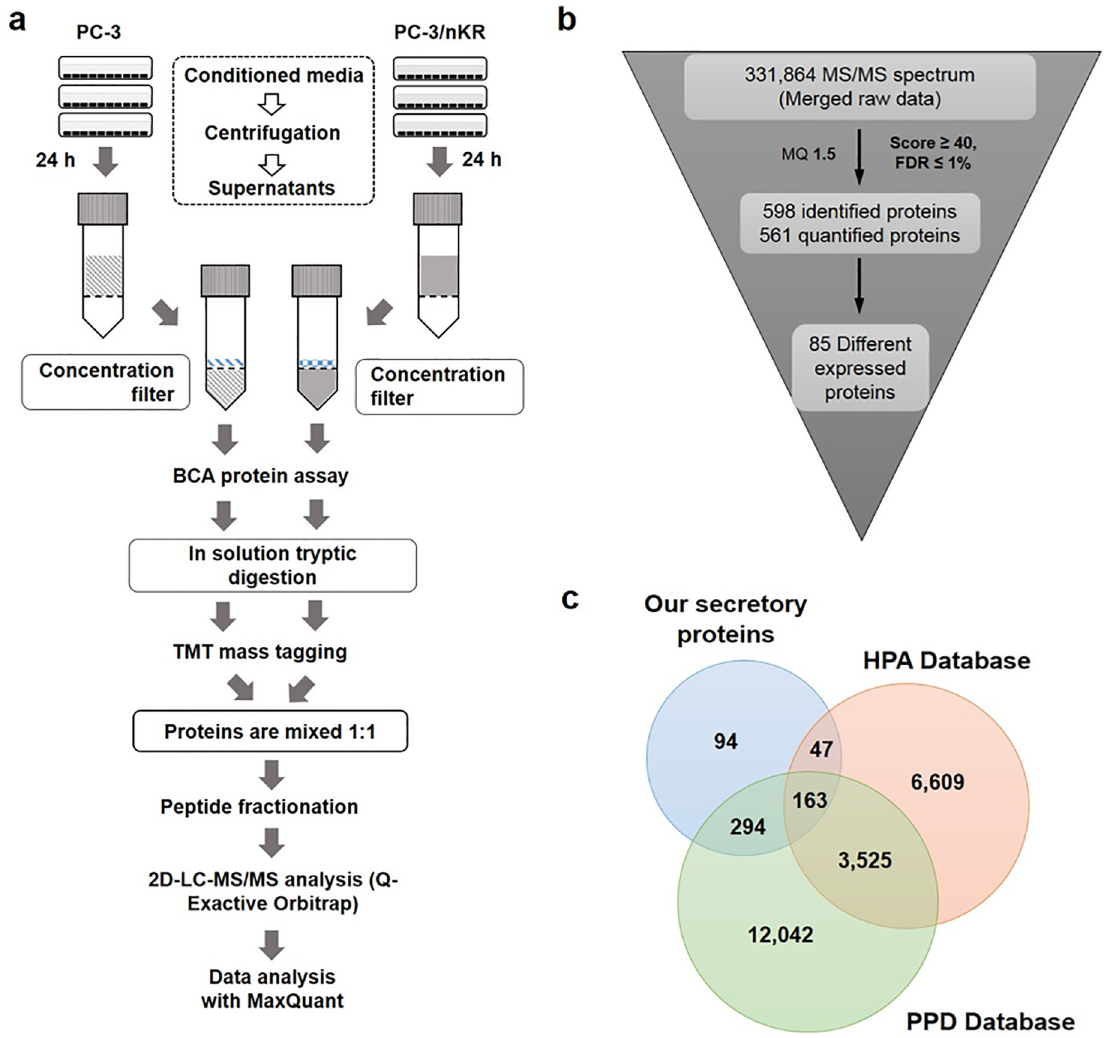
Fig 2. The experimental strategy for the quantitative analysis of the secretomes of PC3 and PC3/nKR cells. (A) The integrated workflow for the comparative proteomics analysis of proteins secreted from PC3 and PC3/nKR cells. (B) A schematic showing the processes for protein identification and quantification based on the results of the proteomic analysis. (C) A Venn diagram indicating that 94 of the 598 proteins that we identified were characterized as newly secretory based upon our results, as determined by comparison with The Human Protein Atlas and Plasma Proteome